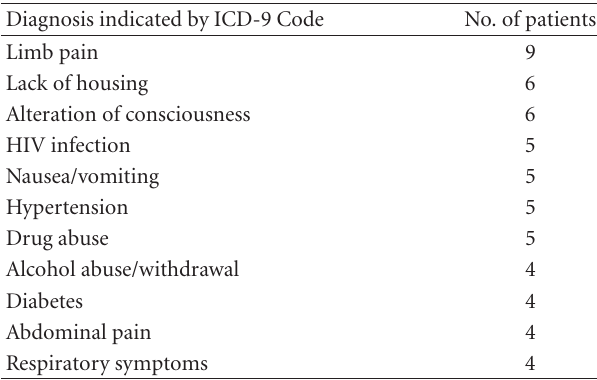
Table 2: Most prevalent diagnoses among 20 frequent ED users. Diagnosis indicated by ICD-9